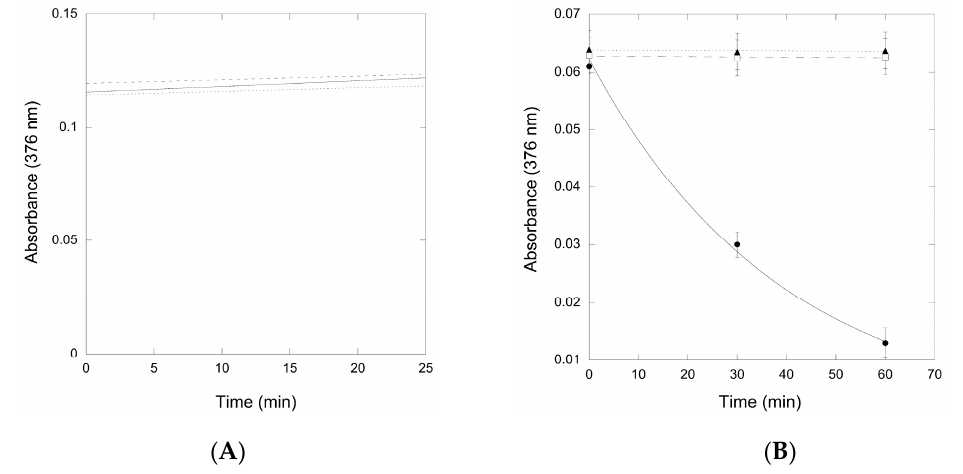
Figure 6. Time ‐ course of the thioimide absorbance (376 nm) from QueF ‐ L/preQ 0 and QueF ‐ L/preQ 0 ‐ Figure 6. Time-course of the thioimide absorbance (376 nm) from QueF-L/preQ 0 and tRNA in the presence of various ammonia donors. ( A ) The absorbance of the QueF ‐ L/preQ 0 thioimide QueF-L/preQ 0 -tRNA in the presence of various ammonia donors. ( A ) The absorbance of the adduct in the presence of ammonium chloride ( ___ ), glutamine ( ‐‐‐ ), or asparagine ( … ). Data show an QueF-L/preQ 0 thioimide adduct in the presence of ammonium chloride (—), glutamine (—), example of a single experiment with each ammonia donor. ( B ) The absorbance of the QueF ‐ L/preQ 0 ‐ or asparagine ( ... ). Data show an example of a single experiment with each ammonia donor; tRNA thioimide adduct in the presence of ammonium chloride (  , ___ ), glutamine ( □ , ‐‐‐ ), or asparagine ( B ) The absorbance of the QueF-L/preQ 0 -tRNA thioimide adduct in the presence of ammonium (  , … ). Data represents the average of three assays, each carried out in replicate with each potential chloride ( ,—), glutamine ( (cid:3) ,—), or asparagine ( (cid:78) , ... ). Data represents the average of three assays, ammonia donor (error bars represent the standard error (SE)). each carried out in replicate with each potential ammonia donor (error bars represent the standard error